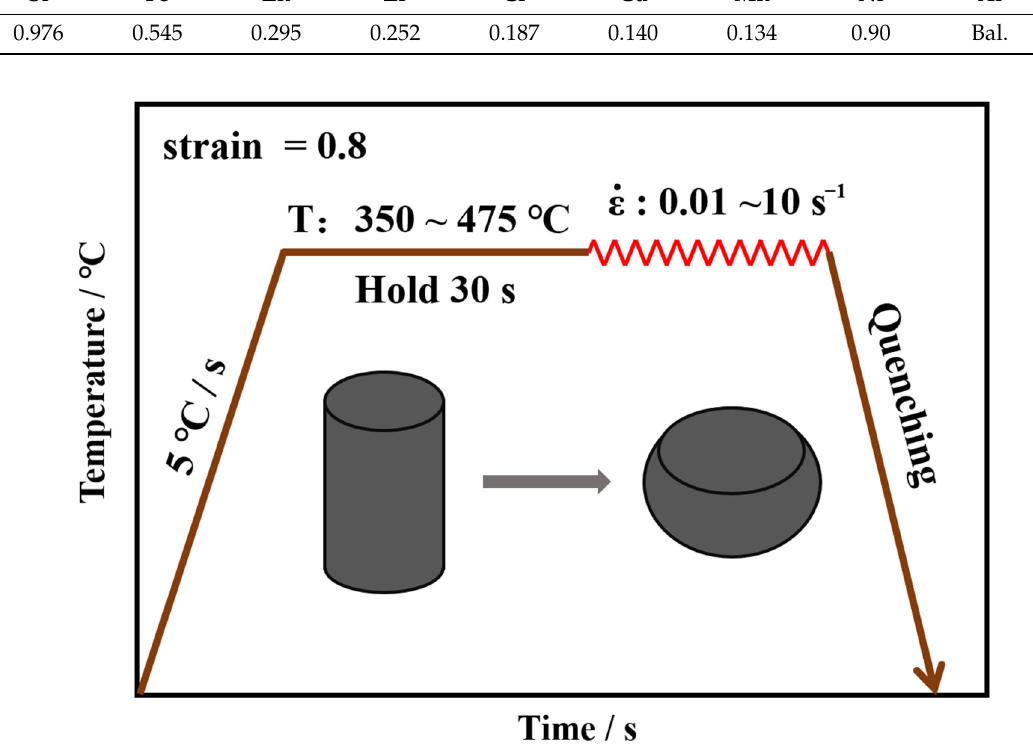
Figure 1. Hot deformation process flow diagram.